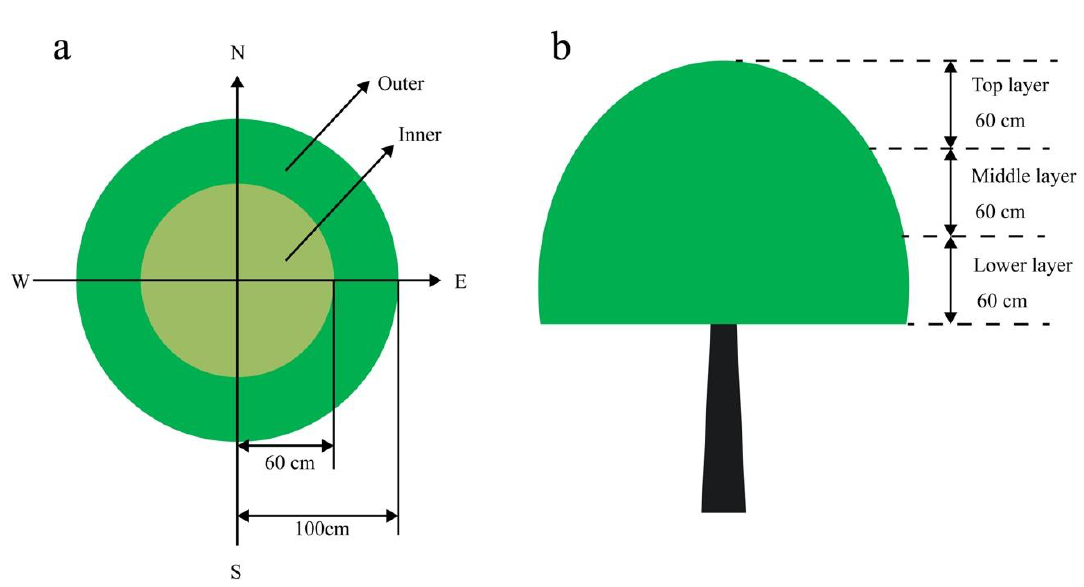
Figure 1. Top and lateral views of the canopy partitions. ( a ) Top view and ( b ) lateral view.